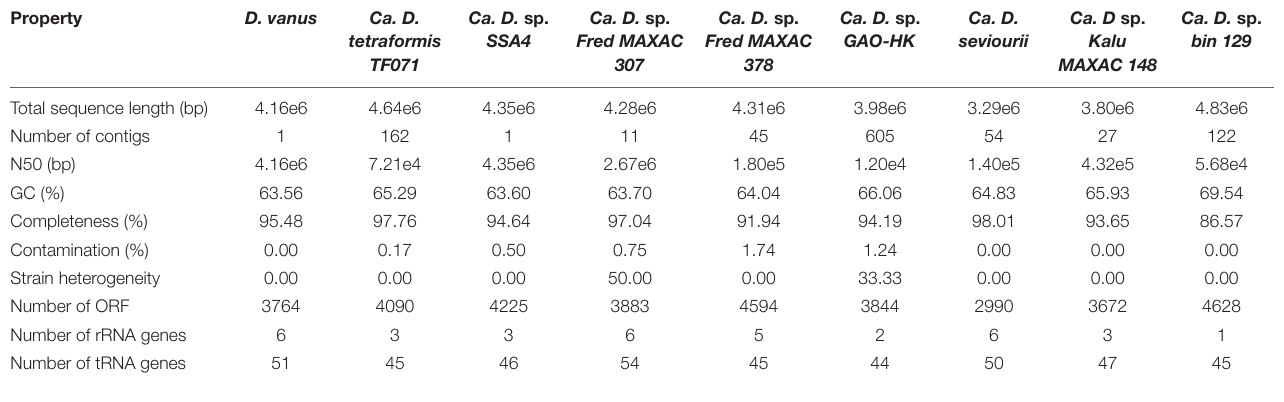
TABLE 1 | Properties of Defluviicoccus genomes examined in this study.